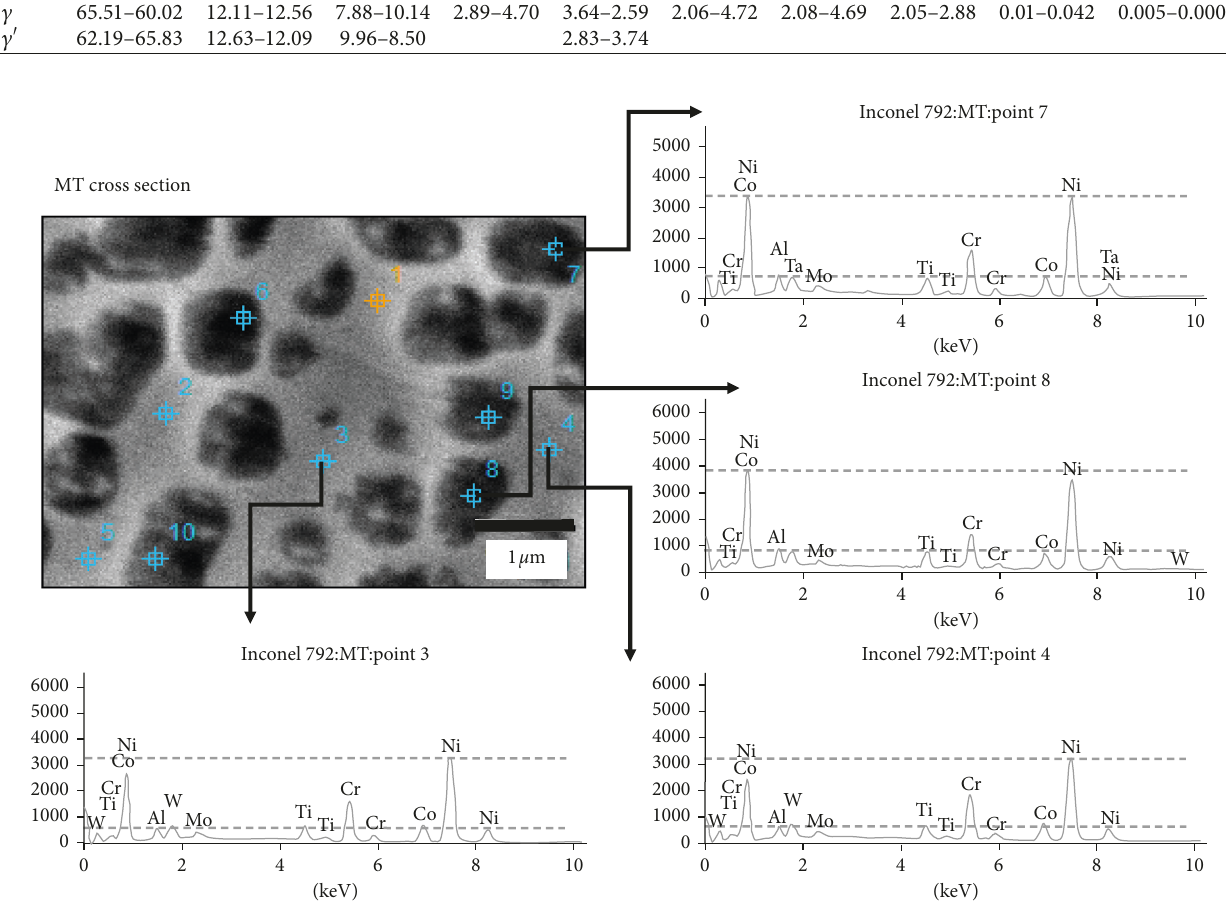
Table 2: Thermo-Calc-calculated chemical composition (wt. %) of c and c ′ phases for as-cast Ni-based superalloy. Phase